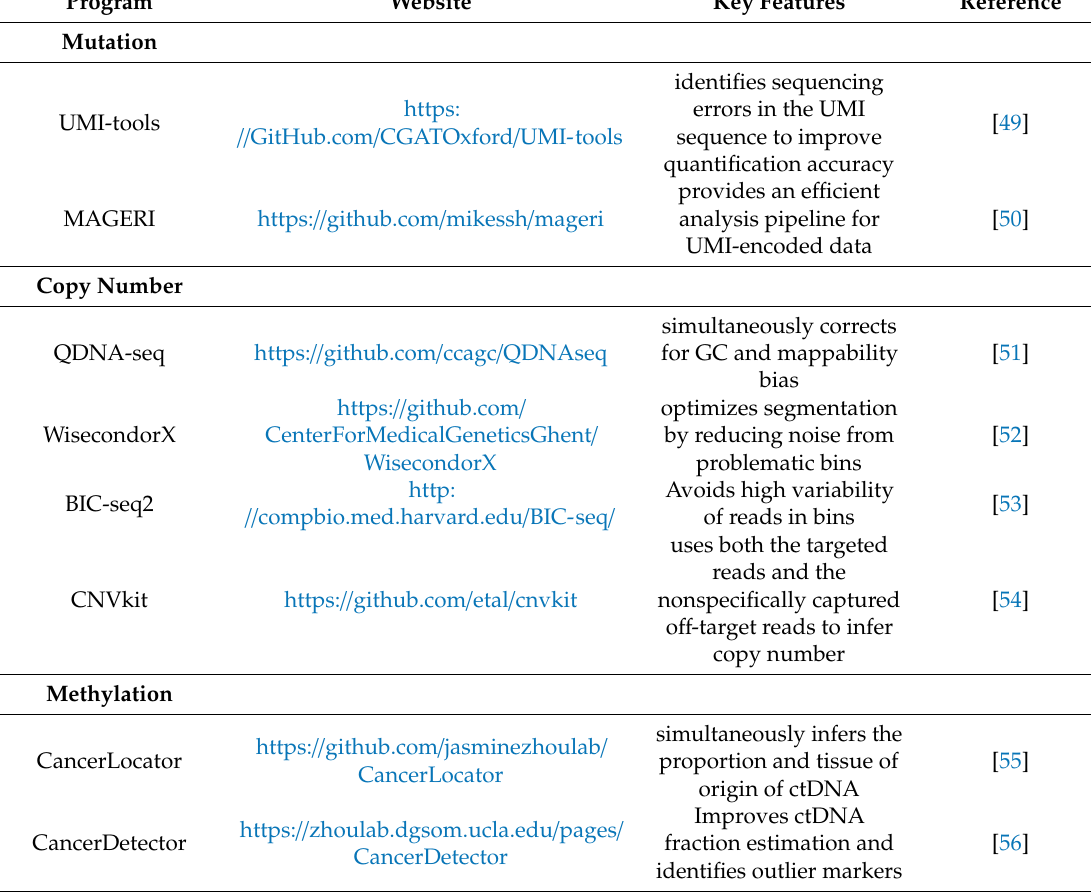
Figure 2. Principle of unique molecular identifiers (UMI) application in the detection of somatic mutations. Table 1. Bioinformatics programs for detecting genetic and epigenetic changes in cancers.